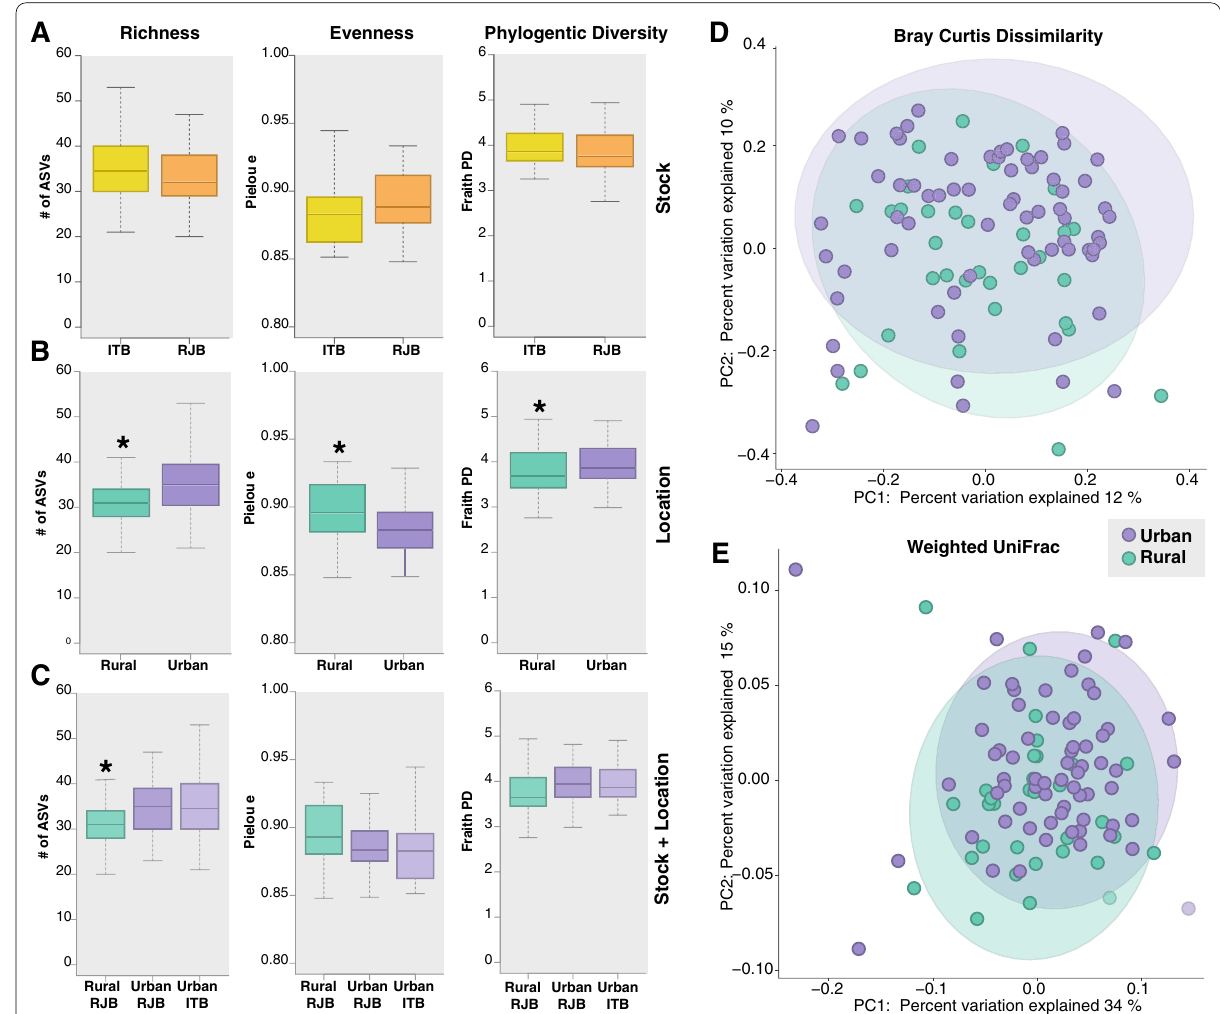
Fig. 2 Alpha and beta diversity analyses. Alpha diversity comparisons of the gut microbiomes of a ITBs and RJBs, b rural and urban bees, and c urban ITB and RJBs and rural RJBs based on richness (# of ASVs), evenness (Pielou’s evenness index) and phylogenetic diversity (Faith’s phylogenetic diversity index). * p -value < 0.05, Kruskal Wallis test. Beta diversity comparisons of the gut microbiomes of urban and rural bees. Principal = coordinate analysis plots based on d Bray Curtis dissimilarity and e weighted UniFrac. Significance was tested using PERMANOVA with 999 permutations (Bray Curtis, p 0.014; weighted UniFrac, p 0.015). Ellipses represent the 95% confidence = =